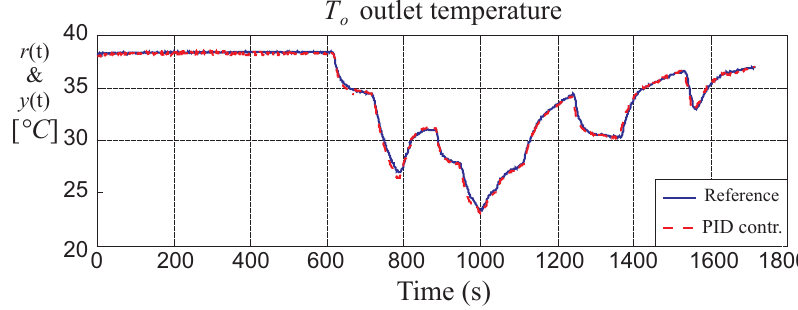
Figure 5. Controlled outlet temperature T o with the PID regulator obtained via the auto-tuning